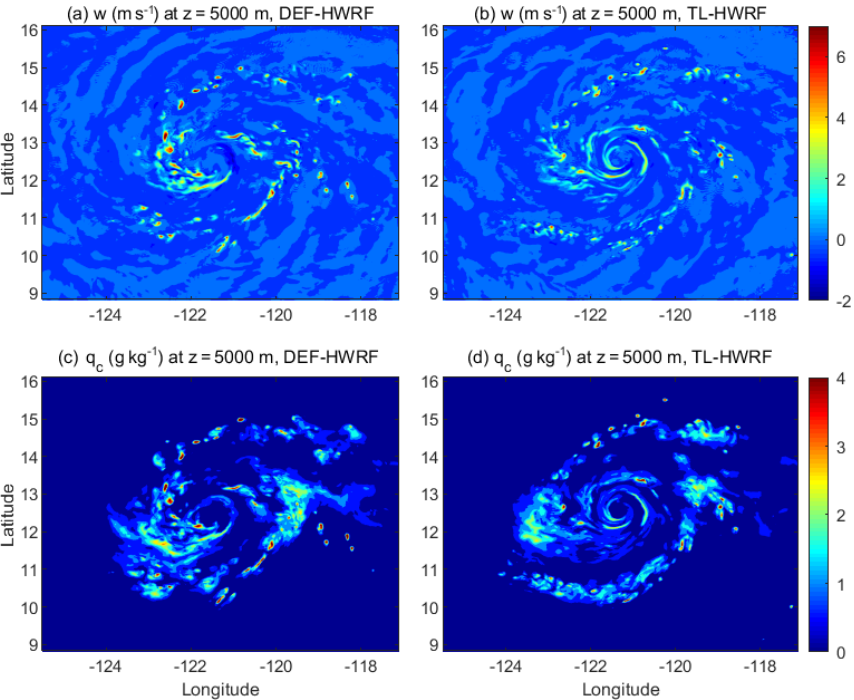
Figure 9. Simulated vertical velocity (ms − 1 ) and hydrometeor mixing ratio (gkg − 1 ) at 5.0km altitude at 12:00UTC, 28 August 2015, by the default HWRF (DEF-HWRF) and the HWRF with the inclusion of an in-cloud turbulent-mixing parameterization